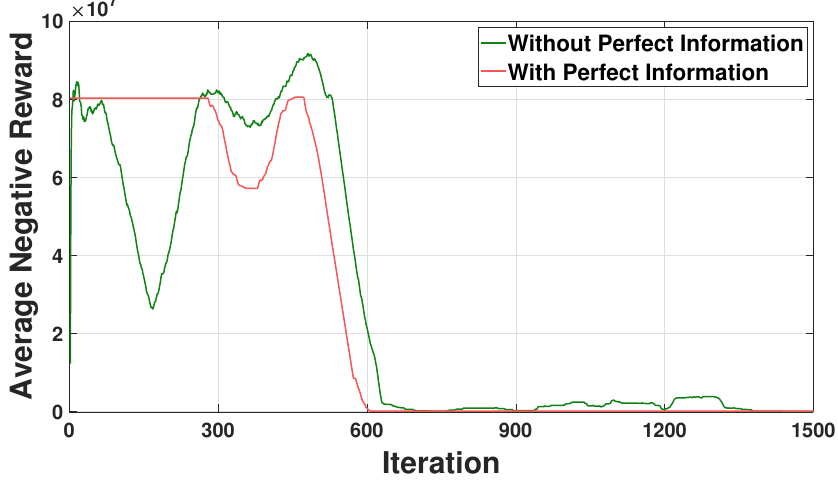
Figure 7. Comparison of average negative reward convergence for the SESS agent between with and without perfect energy consumption information of